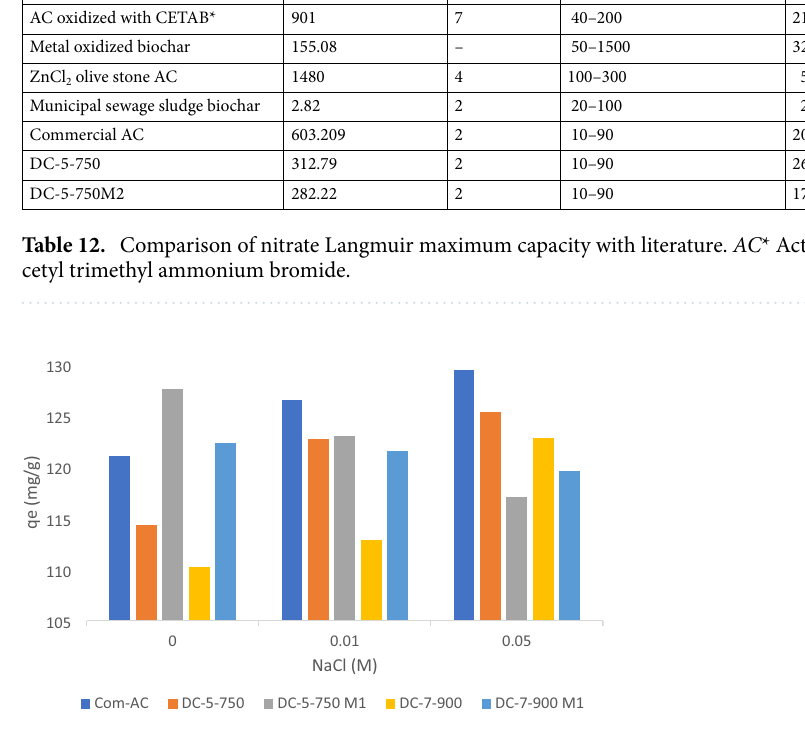
Figure 23. effect of ionic strength on MR uptake.